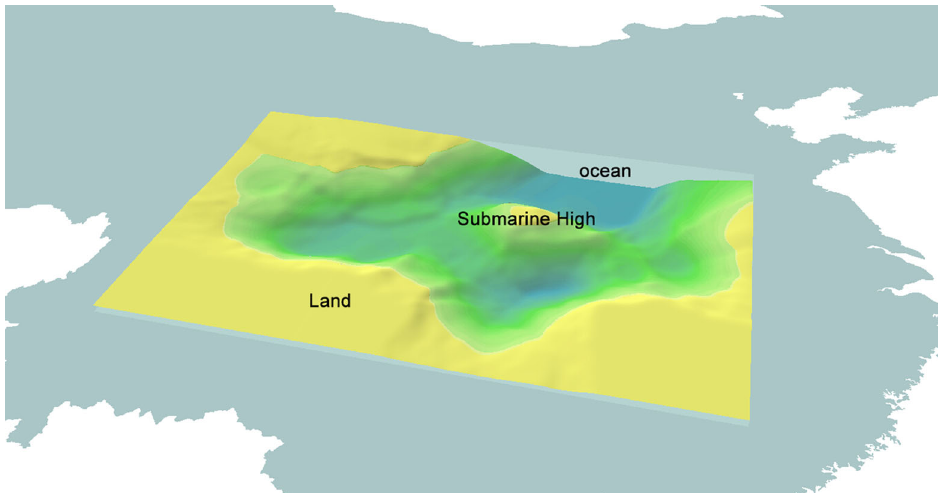
Fig. 3. 3D palaeotopography of the Upper Yangtze region during the Hirnantian. Note that the vertical scale is stretched out to show more details of the topographic